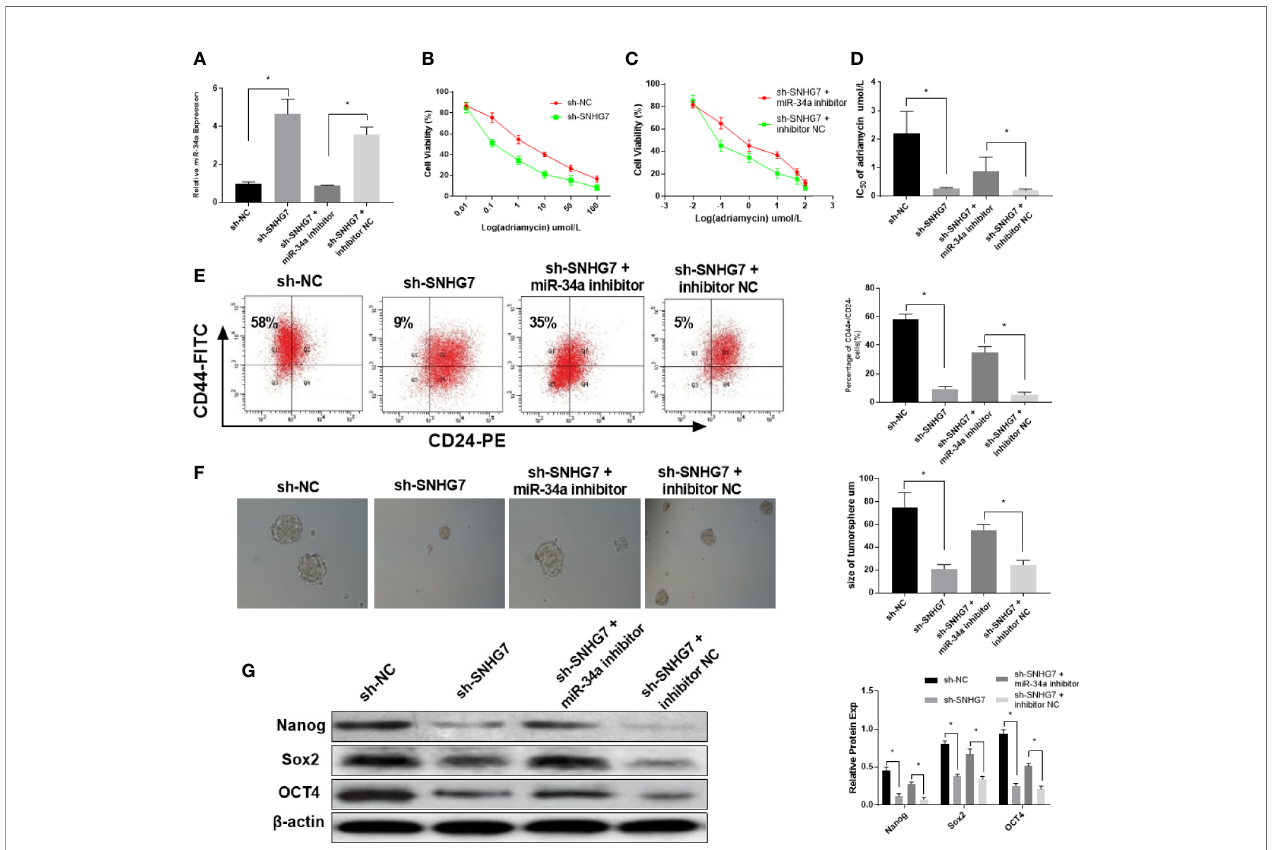
FIGURE 5 | SNHG7 modulated chemoresistance and cancer cell stemness partially via miR-34a. (A) The expression of miR-34a in MCF-7/ADR cells was detected in MCF-7/ADR cells transfected with sh-NC, sh-SNHG7, sh-SNHG7+miR-34a inhibitor and sh-SNHG7+ inhibitor NC by qRT-PCR. (B – D) The IC50 of adriamycin in MCF-7/ADR cells transfected with sh-NC, sh-SNHG7, sh-SNHG7+miR-34a inhibitor and sh-SNHG7+ inhibitor NC was determined by MTT assay. (E) The percentages of CD44+/CD24- MCF-7/ADR cells transfected with sh-NC, sh-SNHG7, sh-SNHG7+miR-34a inhibitor and sh-SNHG7+ inhibitor NC was determined by fl ow cytometry analysis. (F) The diameters of sphere-forming cells in the sh-NC, sh-SNHG7, sh-SNHG7+miR-34a inhibitor and sh-SNHG7+ inhibitor NC groups were determined by sphere formation assay. (G) The protein expression levels of Nanog, SOX2, and OCT4 in MCF-7/ADR cells transfected with sh-NC, sh-SNHG7, sh-SNHG7+miR-34a inhibitor and sh-SNHG7+ inhibitor NC were measured by western blot. *P < 0.05 represent a statistically signi fi cant